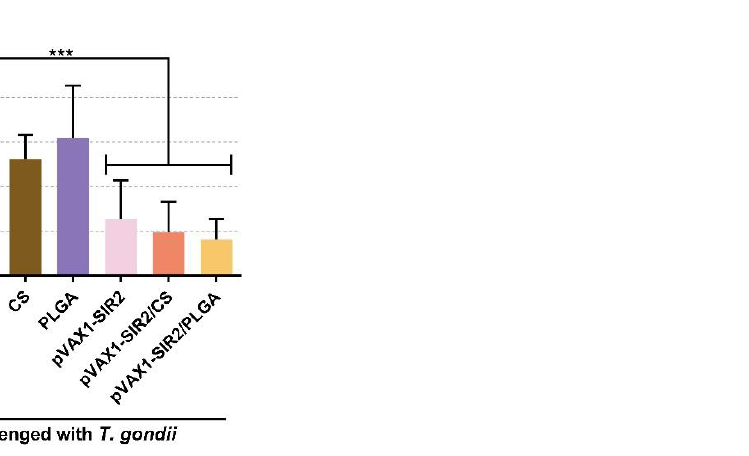
Figure 11. Copy number of T. gondii 529 bp repeat element in cardiac muscles. Immunized animals were challenged with 10 3 tachyzoites two weeks after the second immunization (week four). Seven days after the challenge, cardiac muscles were harvested and investigated. Each sample was investigated three times and values were analyzed by one-way ANOVA analysis followed by Dunnett’s test. Values between the pVAX1-SIR2/CS and pVAX1-SIR2/PLGA group were estimated by the independent t -test. Values were shown as mean ± SD ( n = 5). *** p < 0.001 compared with blank or control group.